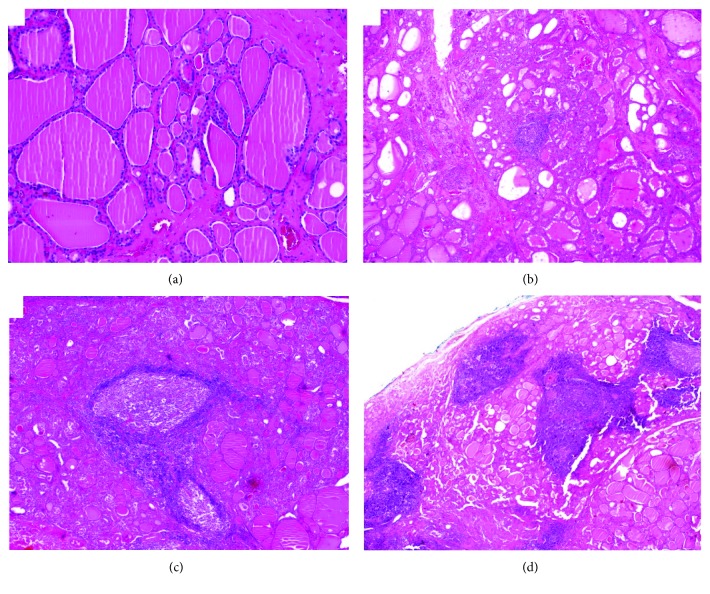
Lymphocytic infiltrate degrees: (a) without infiltrate or infiltrate 0 (×10); (b) light grade or focal infiltrate (×10); (c) moderate degree infiltrate or 2 (×10); (d) intense degree infiltrate or 3 (no magnification).